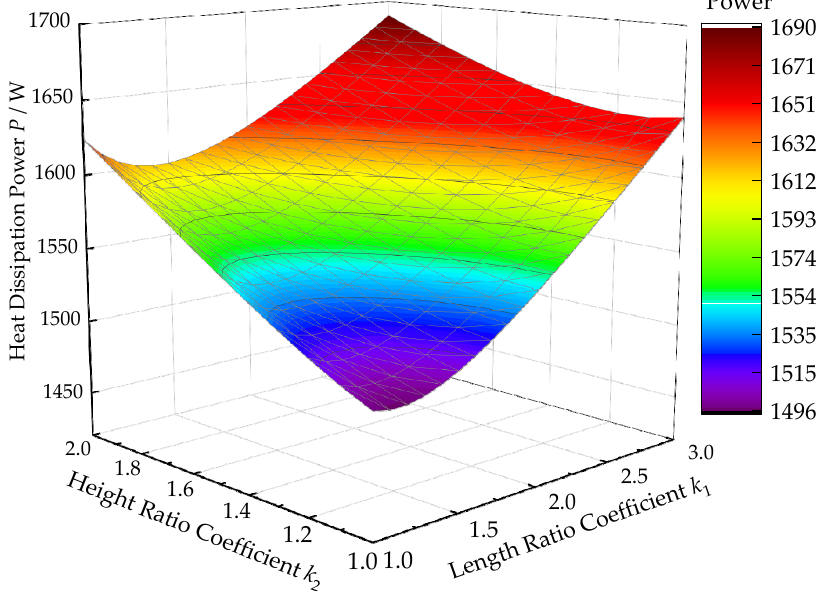
Figure 5. Curve of heat dissipation power with design proportion.